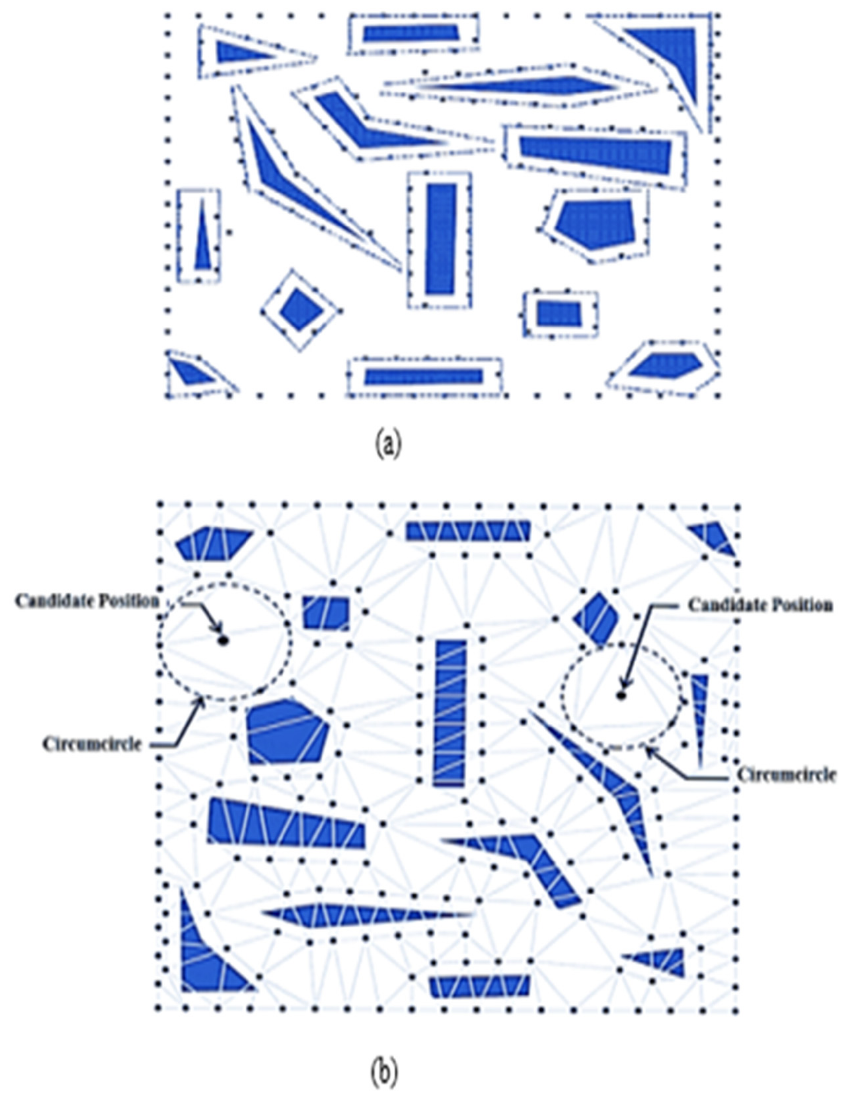
Figure 13. ( a ) The contour points generation step and ( b ) Delaunay triangulation of given sensors.